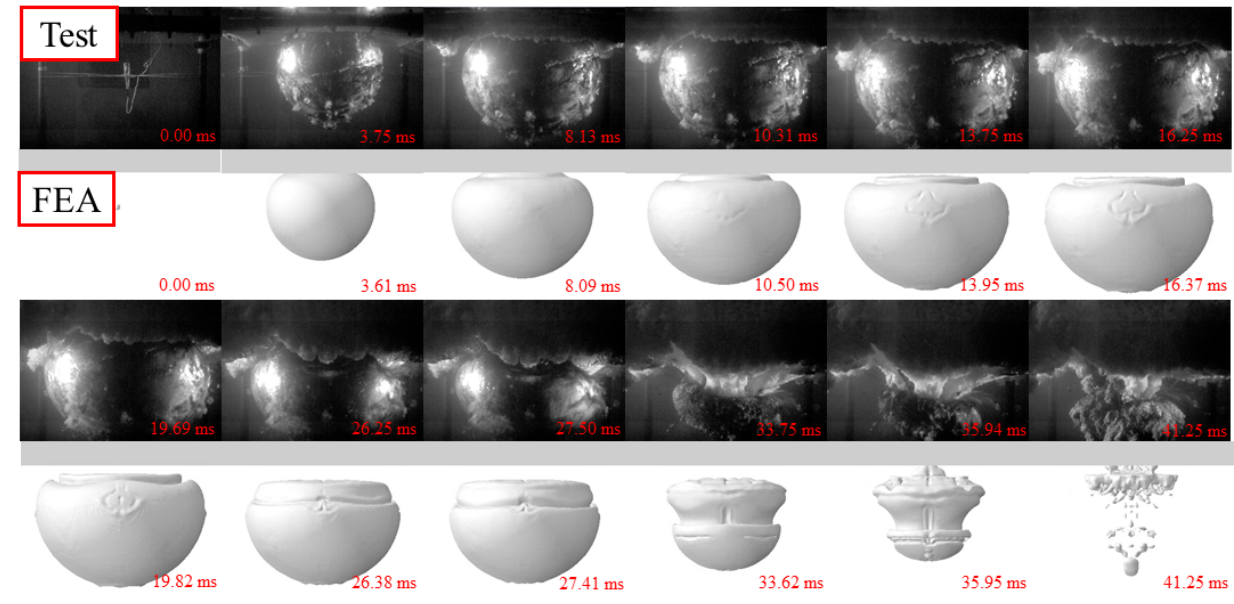
Figure 3. Whole process of underwater explosion for 2.5 g TNT.